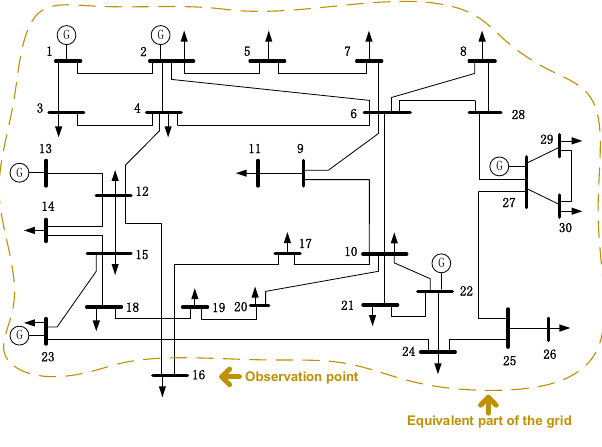
Figure 8. The topology of the IEEE 30-bus system.